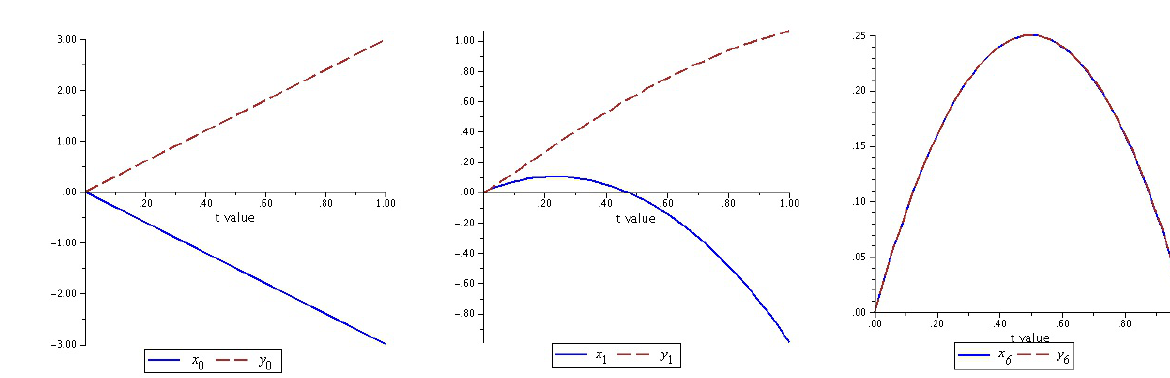
Figure 1: Graphs of x n and y n